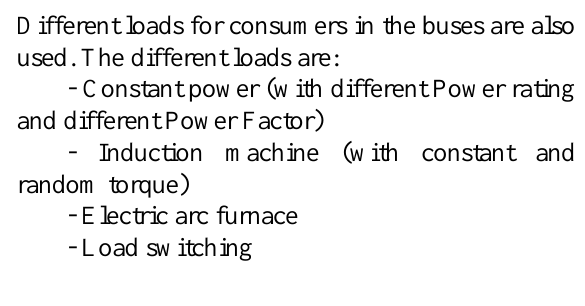
Figure 3. Single line diagram of the MV network under